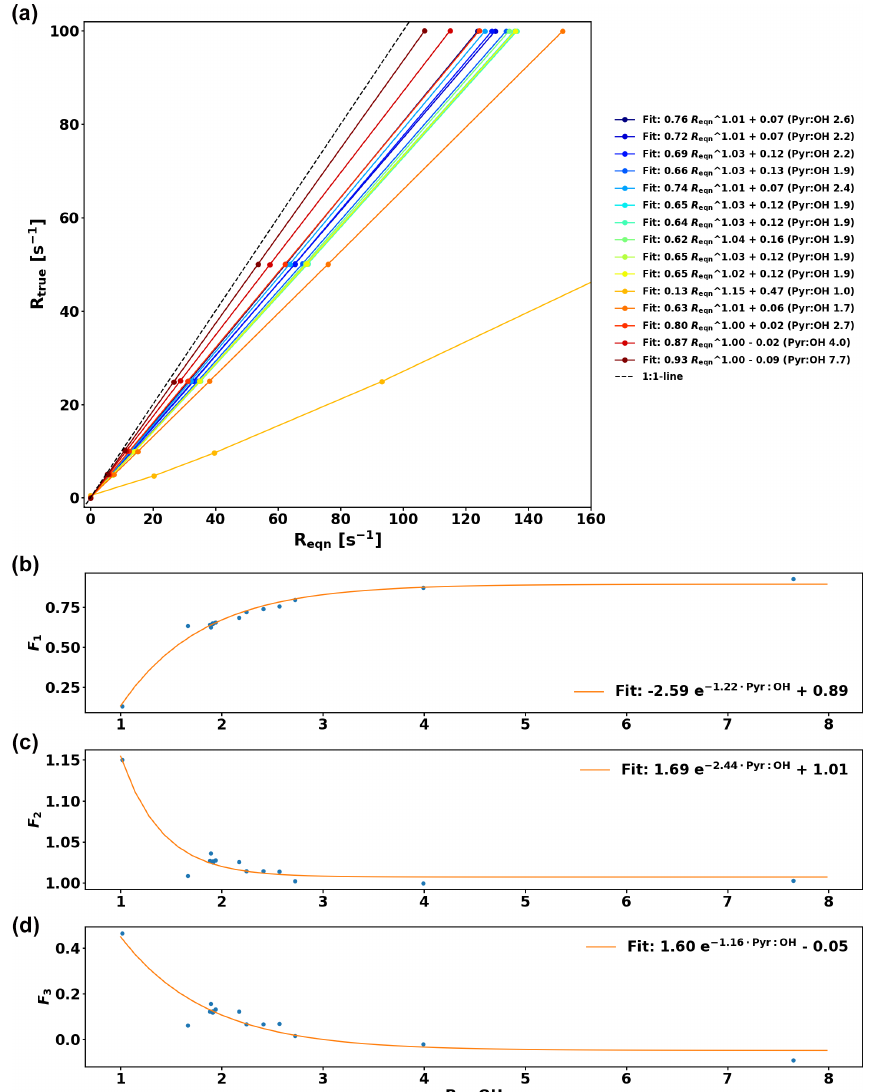
Figure A1. Numerical simulations of R true as a function of R eqn for various pyr / OH values and their corresponding fit curves of the form R true = F 1 × R F 2 eqn + F 3 (a) . Fit coefficients F 1 , F 2 , and F 3 as a function of pyr / OH and corresponding exponential fit curves (b, c, d)